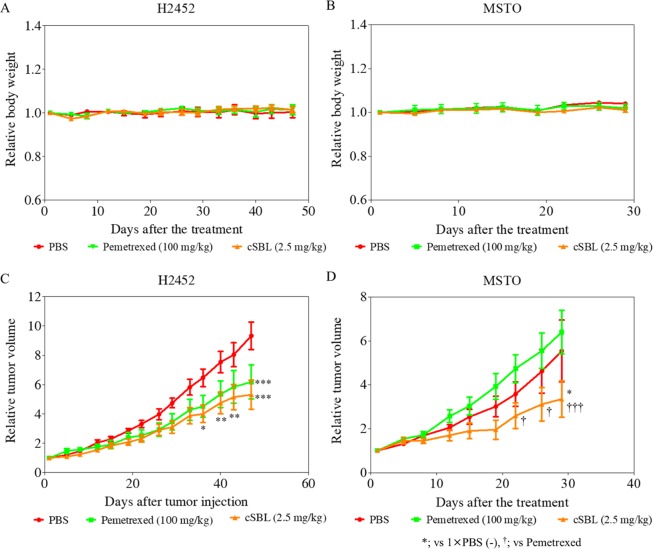
cSBL showed in vivo cytotoxicity without inducing loss of body weight.Mice were randomly divided into 3 groups with 10 mice in each group. Groups 1, 2, and 3 were injected PBS, pemetrexed (100 mg/kg, intraperitoneally), and cSBL (2.5 mg/kg, intratumorally), respectively. Body weights and tumor sizes were measured twice per week. Tumor volumes were calculated as follows: 0.4×A×B2, where A and B represent the long and short diameters (in mm) of the tumor, respectively. Relative body weight (A, B) and relative tumor volume (C, D) are plotted as the mean of each group ± SD at each timepoint. The statistical significance of these experiments compared with PBS (*) or pemetrexed (†) is shown as follows: *P<0.05, **P<0.01, ***P<0.001, †P<0.01, †††P<0.001.